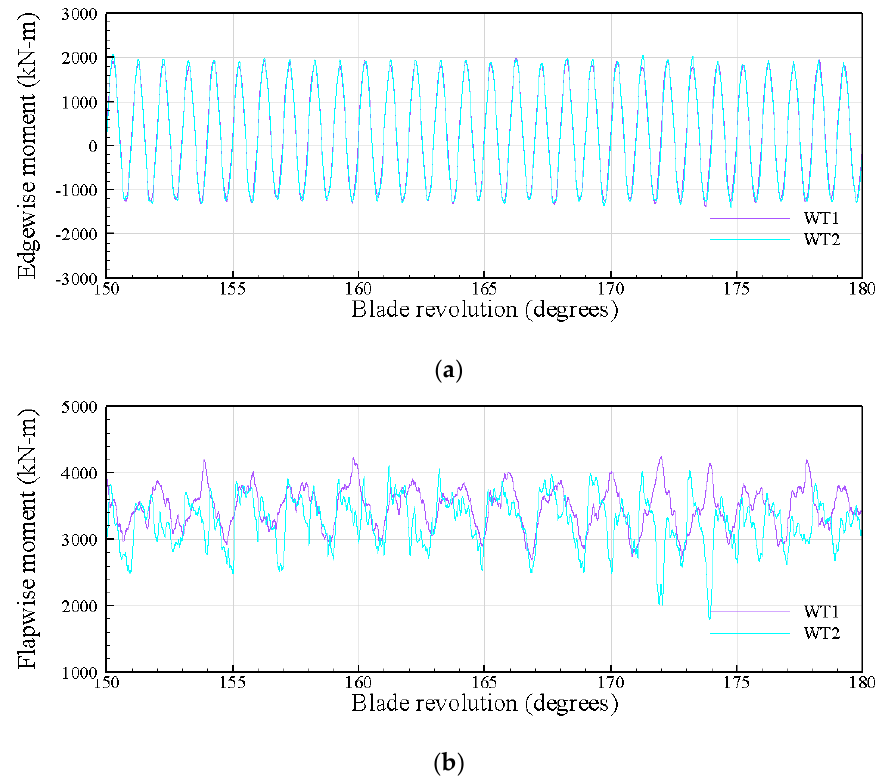
Figure 16. ( a ) Edgewise and ( b ) flapwise blade root moment from SOWFA.